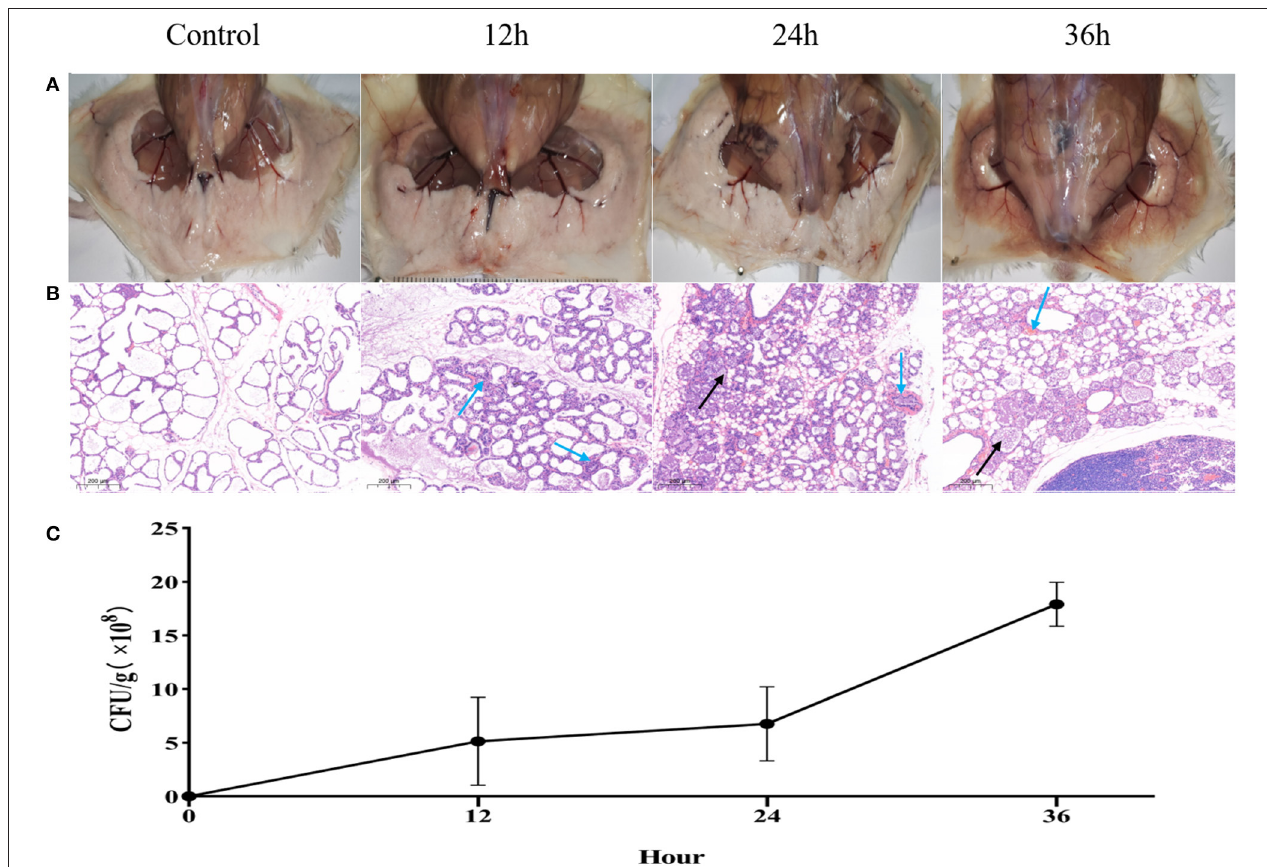
FIGURE 3 | Inflammation and histological evaluation and bacterial burden of murine mammary gland after intramammary inoculation with Helcococcus ovis. (A) Pathological changes in murine mammary glands challenged with Helcococcus ovis . (B) Helcococcus ovis infection induced slight murine mastitis: infiltration of inflammatory cells (mainly neutrophils) into gland alveoli (black arrow) and stromal hyperplasia and progressive mammary alveolar damage (blue arrow). (C) Bacterial burden in mammary glands of mice (up to 36h after inoculation). Each time point represents five mice in each of the four groups. Data are mean ± SD of three independent